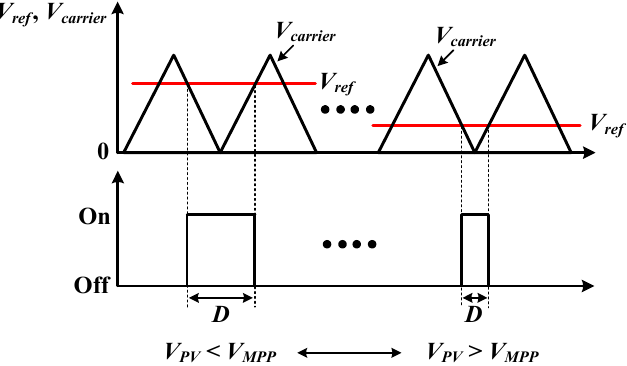
Figure 10. Flow chart of the proposed MPPT algorithm.